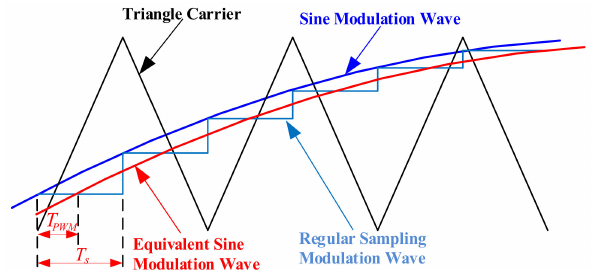
Figure 4. Time delay caused by the asymmetry